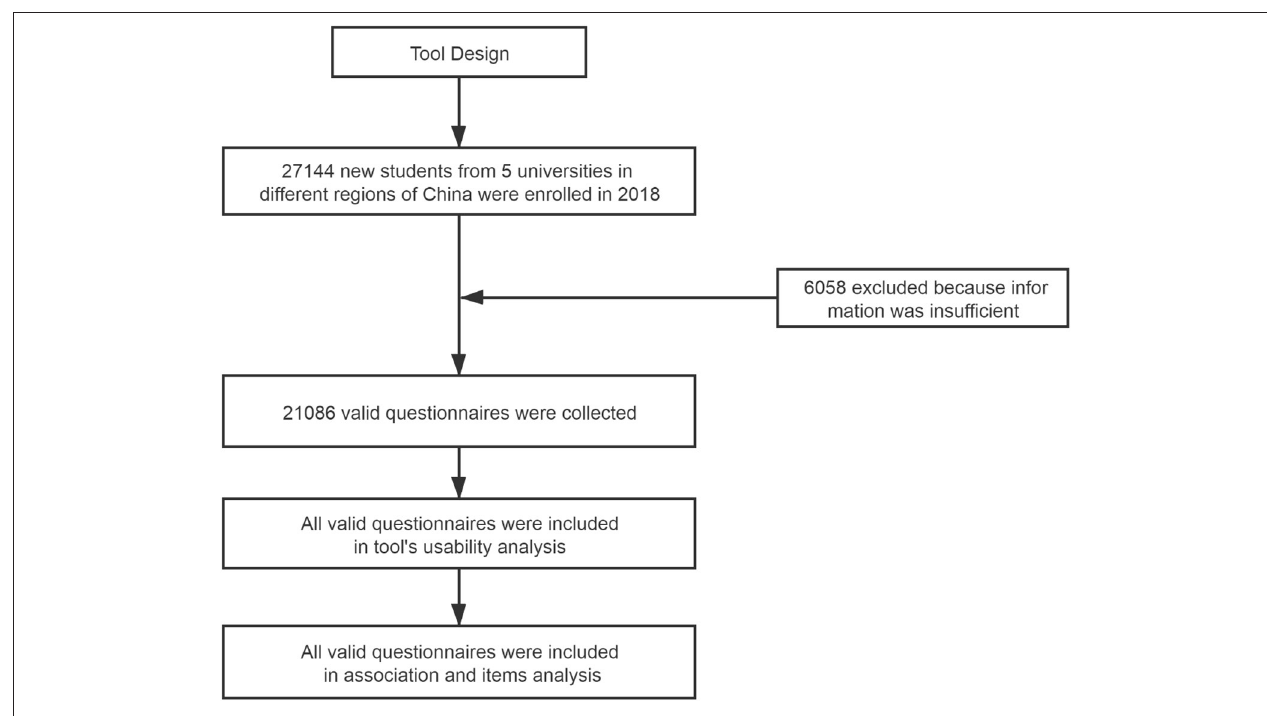
FIGURE 1 | Investigation